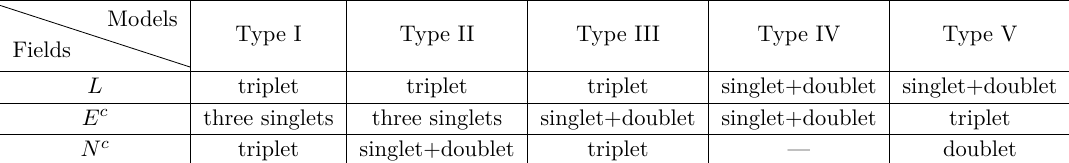
Table 2 . The representation assignments of lepton matter fields L , E c and N c under the finite modular group Γ 0 in the five types of 6